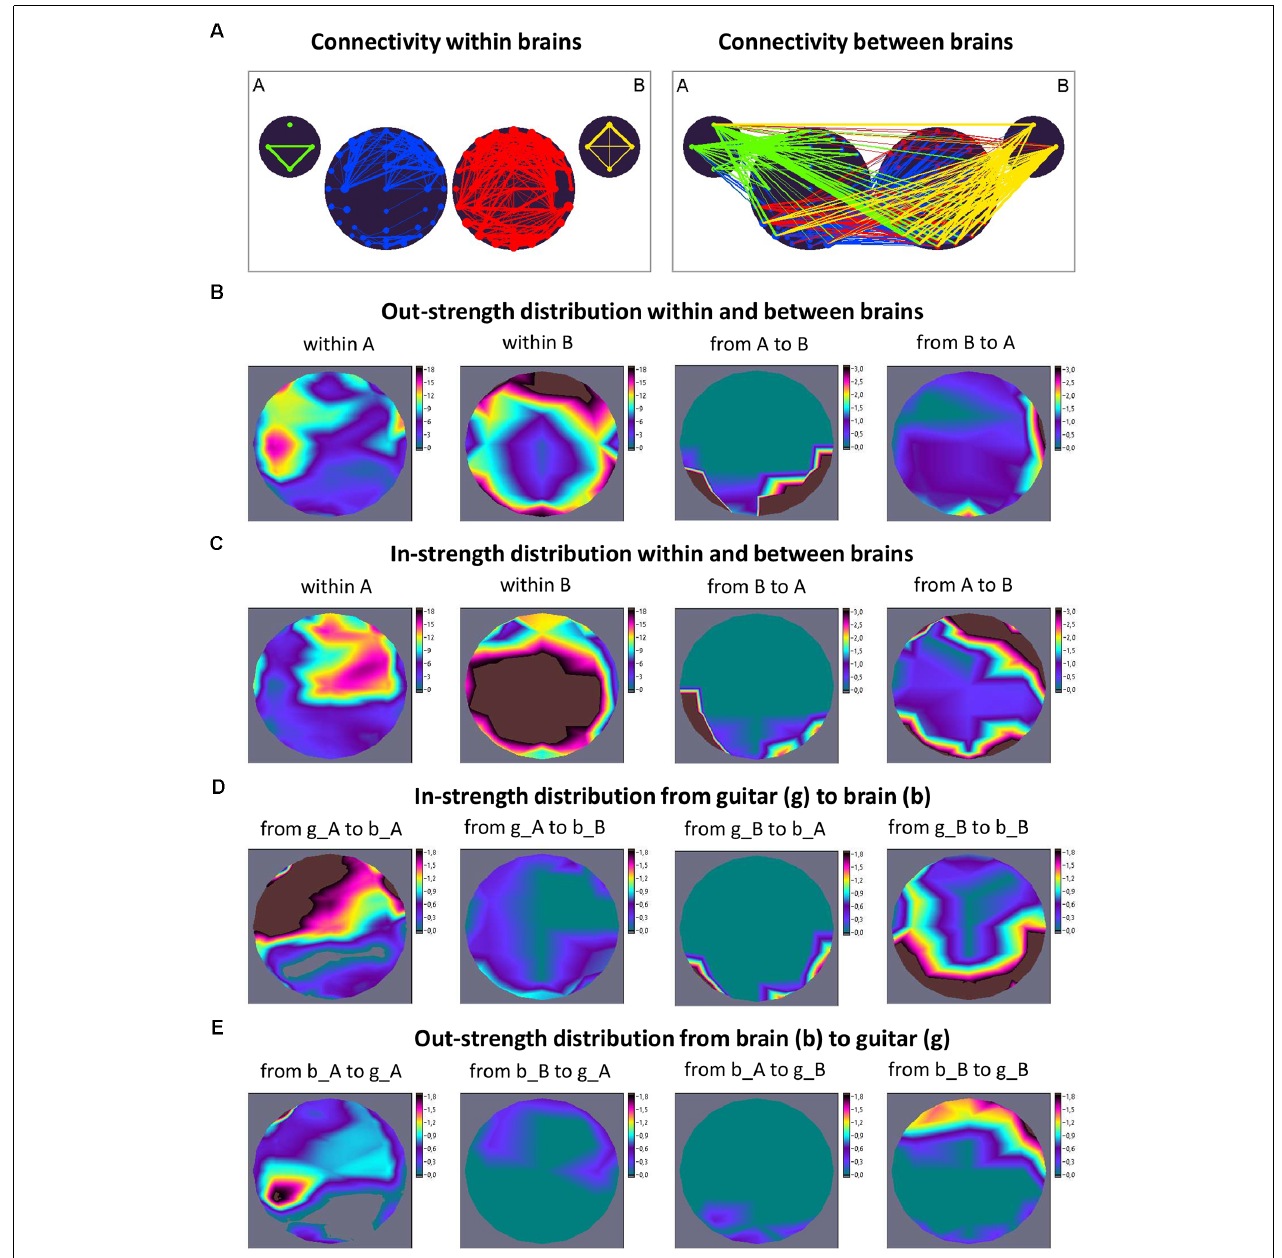
FIGURE 1 | Connectivity within and between the brains and instruments and corresponding strength distributions during free guitar improvisation. (A) Connectivity maps. The left panel represents the connectivity between the guitars and brains, and the right panel represents the connectivity between the guitars and brains. The strength of the nodes (sum of all out-going connections) is coded by circle size, and the strength of edges is coded by line thickness. The different parts of the network are color-coded: guitar A, green; guitar B, yellow; guitarist A’s brain, blue; guitarist B’s brain, red. The guitars comprise four nodes each, indicating different frequency ranges of auditory signals ordered clockwise from top: low, middle, high, and whole range (see text). The brains comprise 40 nodes (electrodes) each. (B) Out-strength distribution within and between brains. The two maps on the left represent the topological distribution of the out-strengths within the brains of the two guitarists, and the ones on the right display the topological distribution of the out-strengths going from guitarist A’s brain to guitarist B’s brain and vice versa . (C) In-strength distribution within and between brains. The two maps on the left represent the topological distribution of the in-strengths within the brains of the two guitarists, and the ones on the right display the topological distribution of the in-strengths coming from guitarist B’s brain to guitarist A’s brain and vice versa . (D) In-strength distribution from the guitar (g) to the brain (b). The strength distribution maps from left to right represent the topological distribution of the in-strengths coming from guitar A to brain A, from guitar A to brain B, from guitar B to brain A, and from guitar B to brain B. (E) Out-strength distribution from the brain (b) to guitar (g). The strength distribution maps from left to right represent the topological distribution of the out-strengths coming from brain A to guitar A, from brain B to guitar A, from brain A to guitar B, and from brain B to guitar B. It can be seen that the guitars address brain regions in the two brains that are interconnected as well as those that are not. In addition, there are connections between the brains that are not connected with the guitars (adapted from Müller and Lindenberger, 2019).